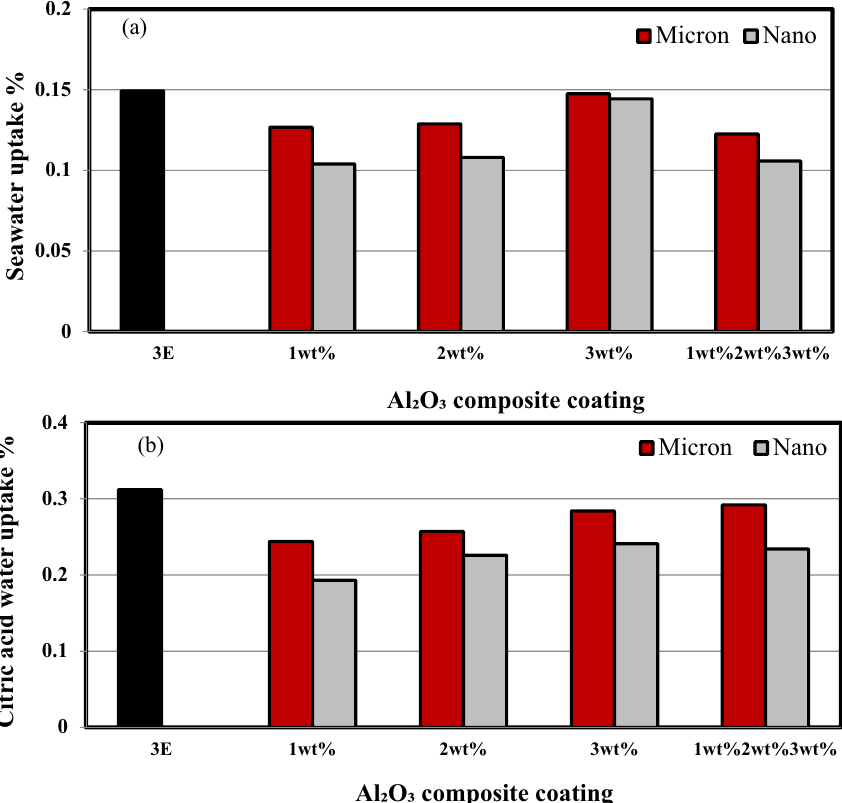
Figure 9. The barrier properties of multilayers epoxy coating to steel substrate filled with ( a ) Al 2 O 3 microparticles ( b ) Al